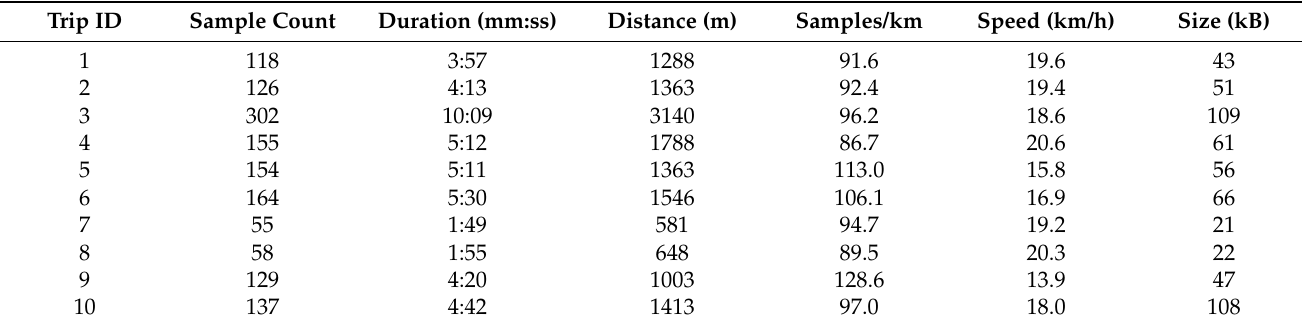
Table 1. Characteristics of the simulated vehicles’